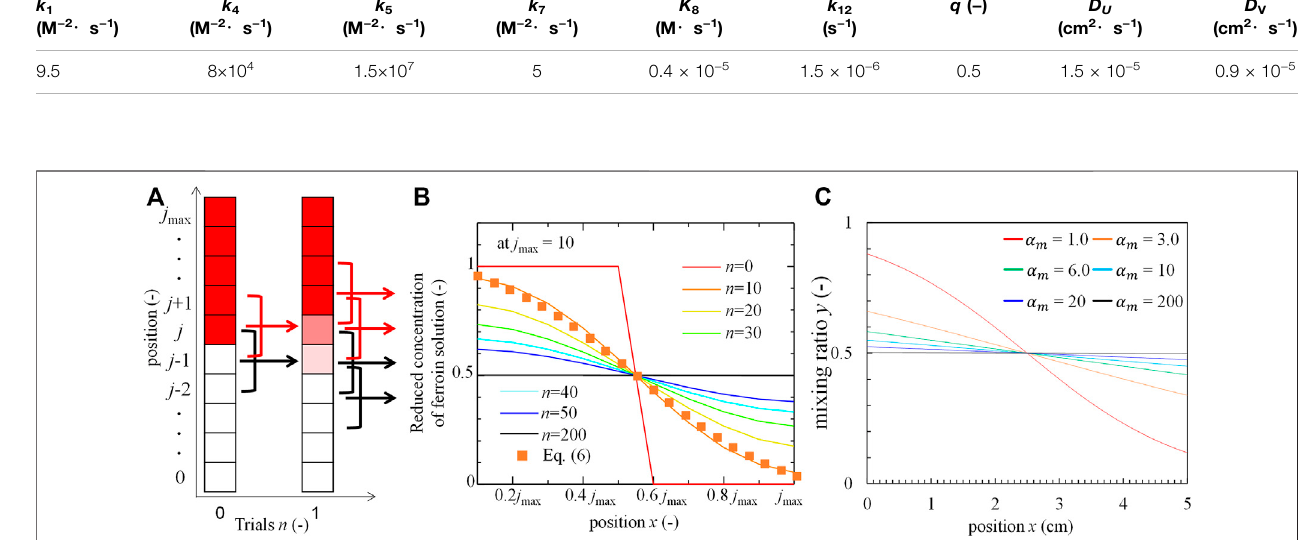
FIGURE 5 | Mixing model and distributions. (A) Schematic of the model (the arrows indicate that three portions mix into one region), (B) Distribution of ferroin concentration at each trial obtained from the model. (C) The ratio of BZ solution to the local solution with s in calculation fi t by hyperbolic tangent